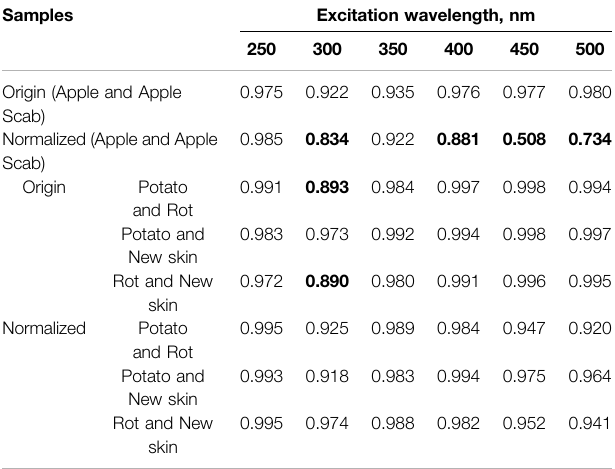
TABLE 1| Correlation coef fi cients ofthespectraofahealthy applesurface andan infected scab for excitations with different wavelengths (highlighted in gray). Below are the correlation coef fi cients of the spectra of the healthy surface of potatoes, potatoes prone to rot and the place of new skin after mechanical damage. Correlation coef fi cient values < 0.9 are marked in